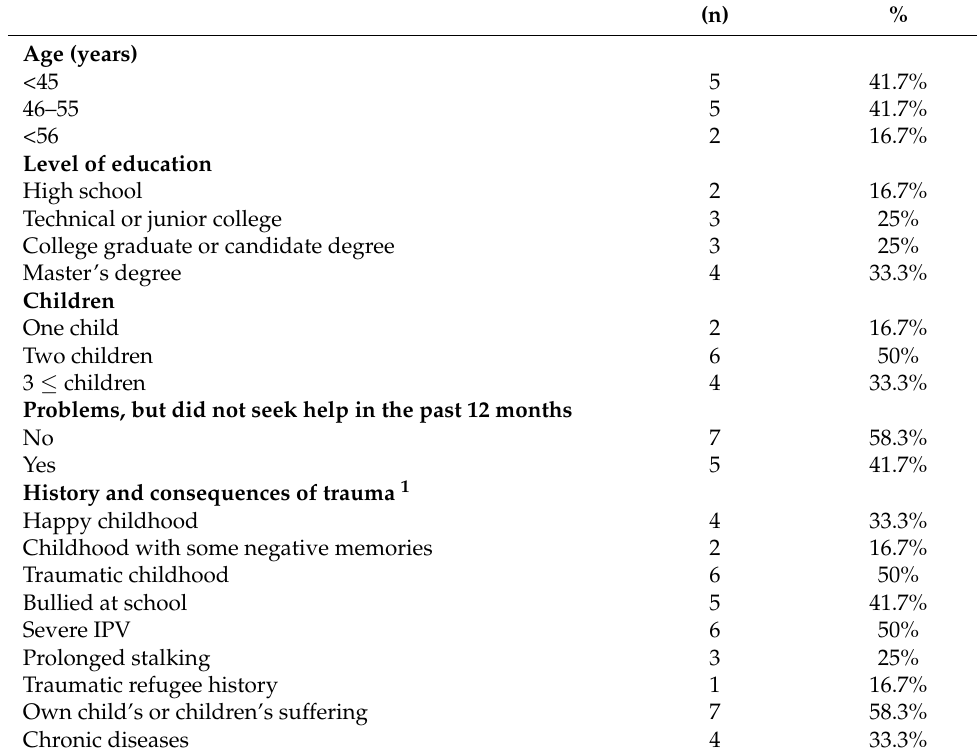
Table 1. Background of the participants.